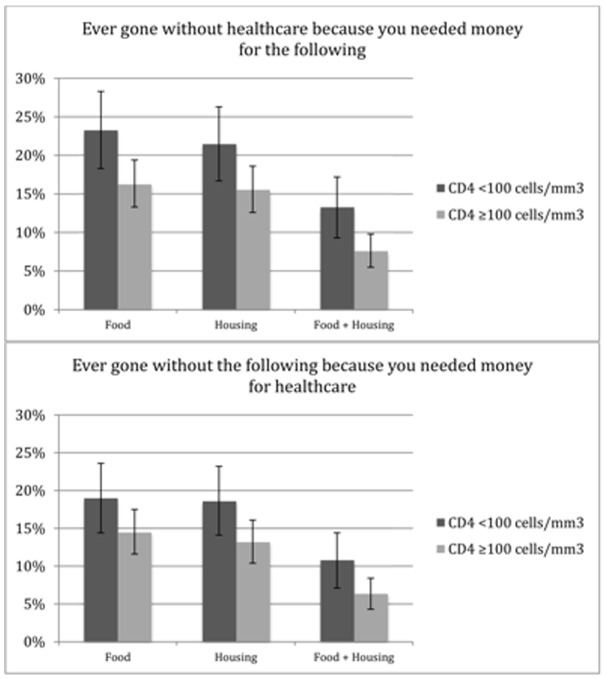
Competing needs to receiving healthcare among those with and without late-stage disease (CD4<100 cells/mm3) at the time of initial HIV diagnosis (N = 830).Error bars represent 95% confidence intervals.